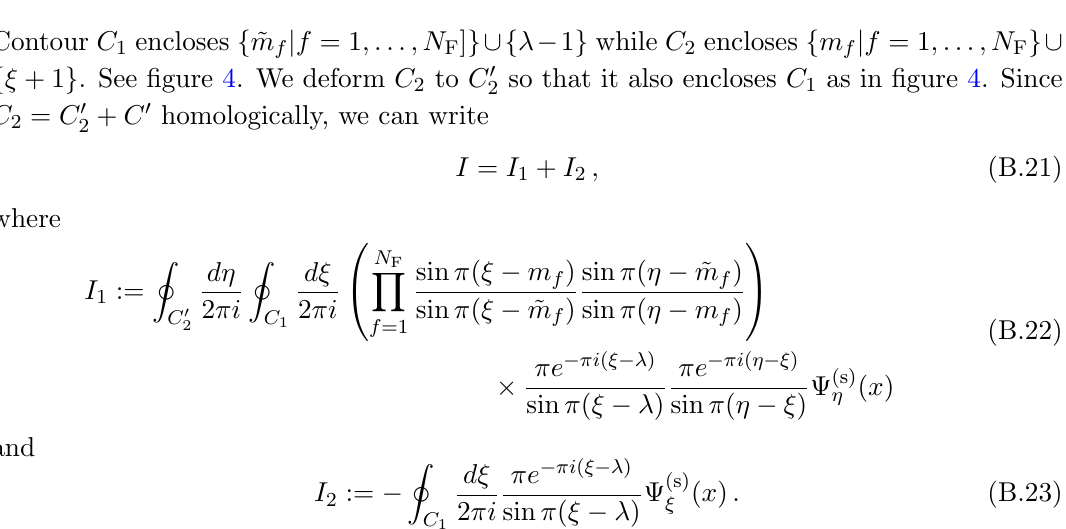
Figure 4 . Deformation of the integration contour C 2 to C 0